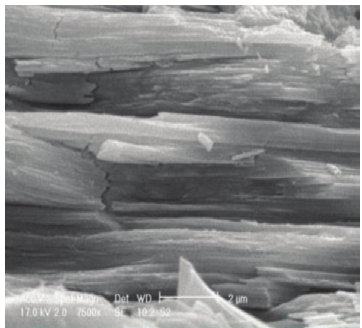
Fig. 17. Electron microscope image of 28 day curing samples with 5% Lime and 10%